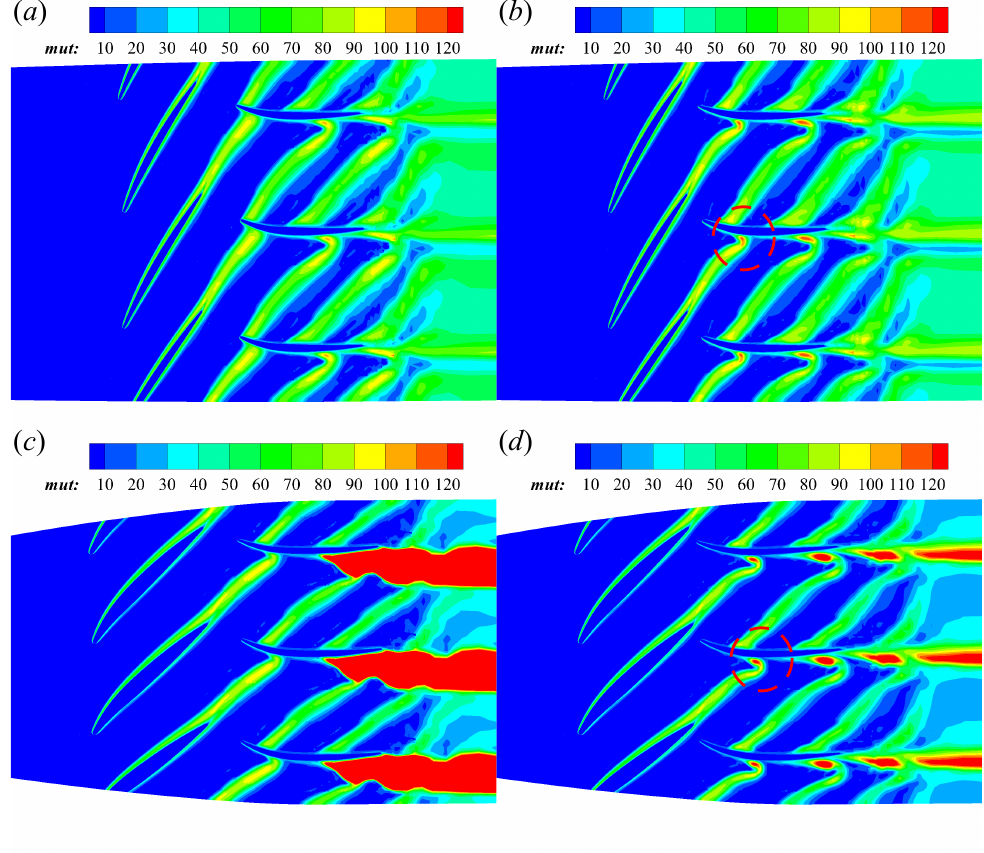
Figure 17. Flow contours of turbulence viscosity on two span sections at φ = 0.318 for the two gaps: ( a ) 90% span and g = d 0 ; ( b ) 90% span and g = 0.1 d 0 ; ( c ) 20% span and g = d 0 ; ( d ) 20% span and g = 0.1 d 0